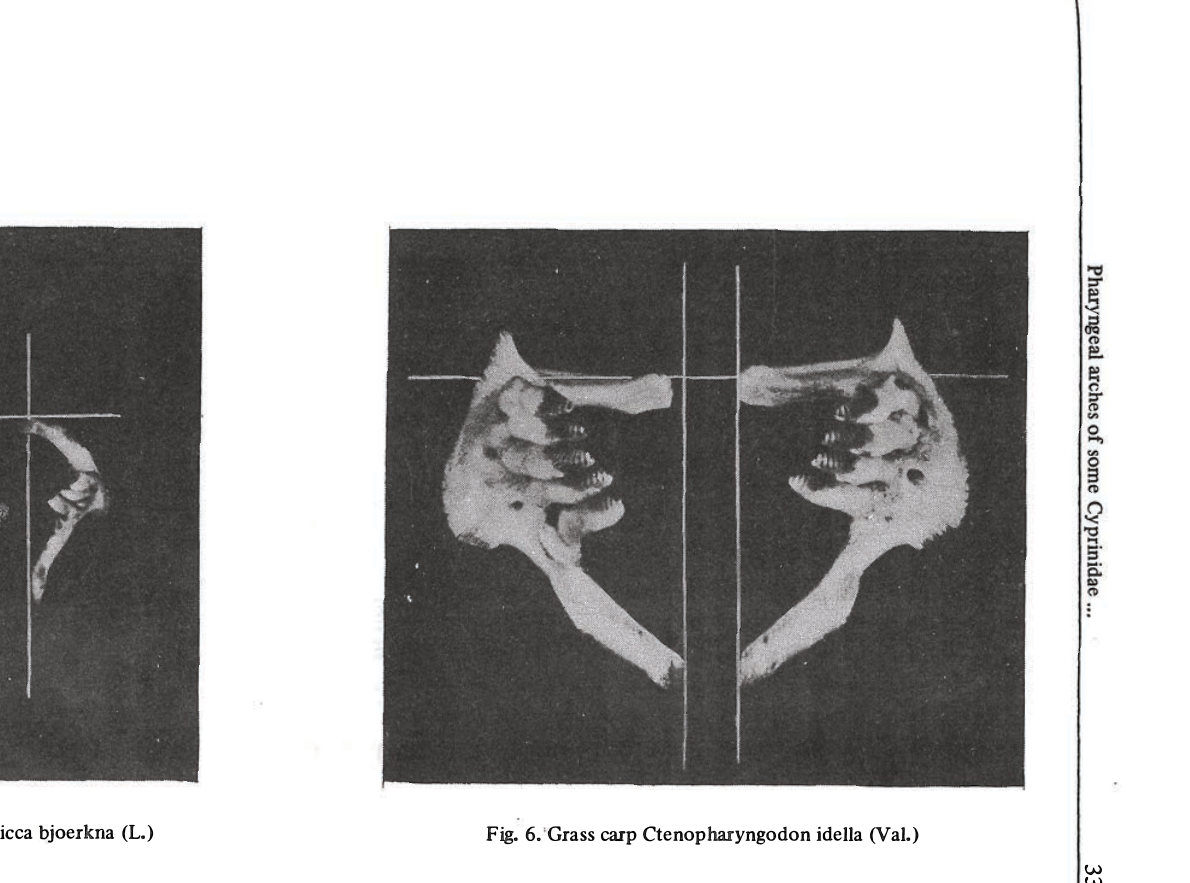
Fig. 5. With bream Blicca bjoerkna (L.) Fig. 6. Grass carp Ctenopharyngodon idella (Val.)